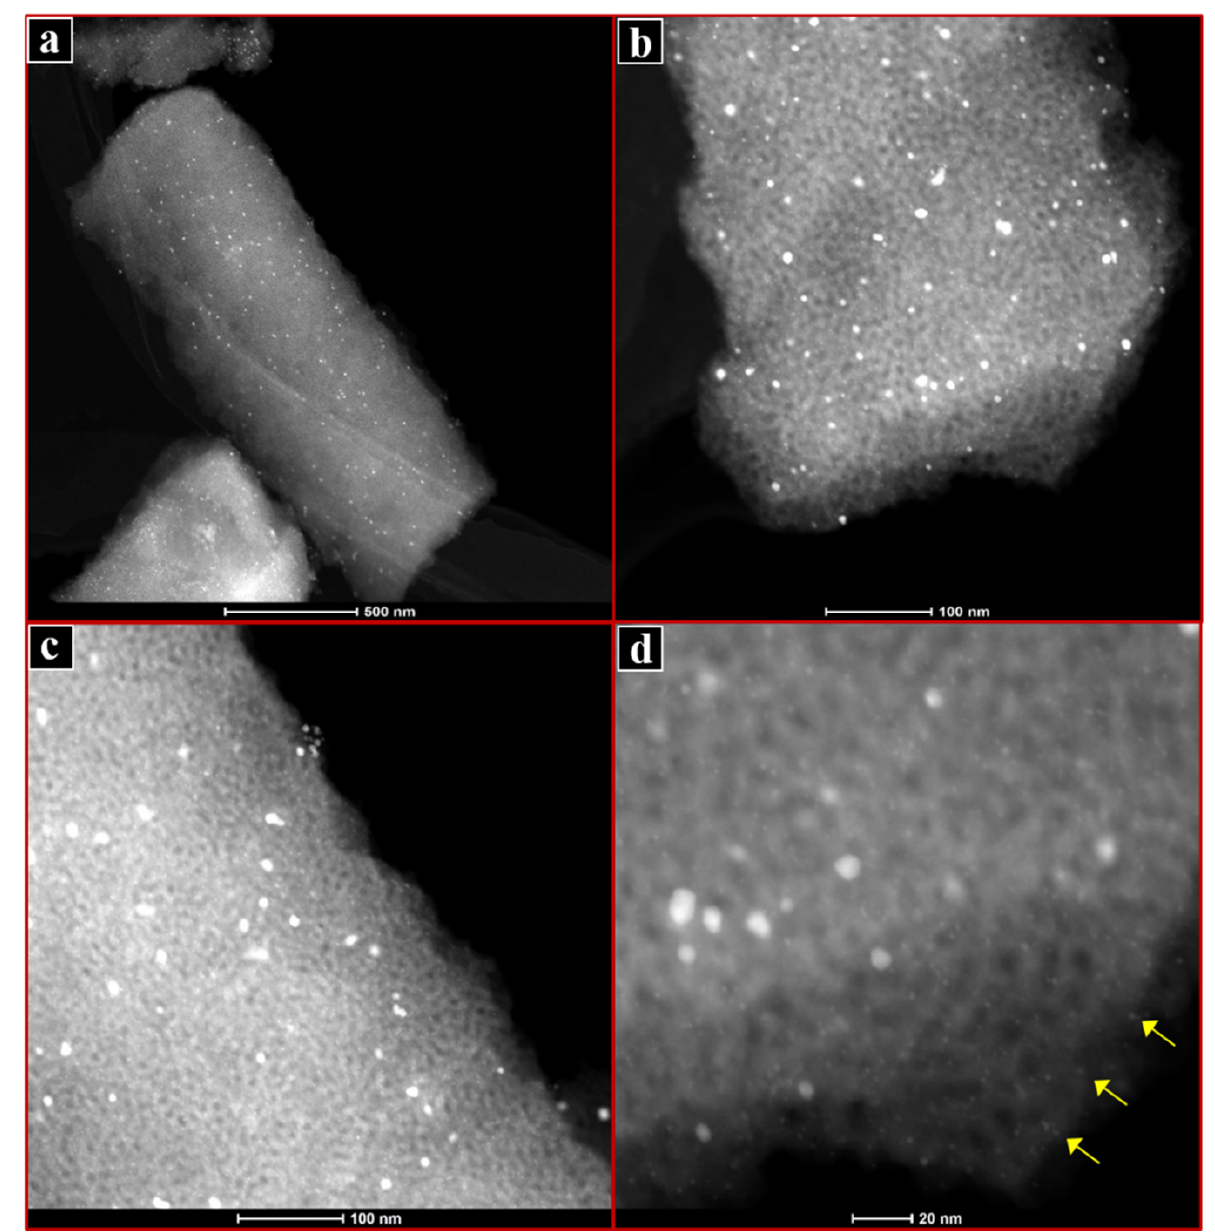
Figure 4. HAADF images of the catalyst IW-Pd after HDC testing in which Pd has bright contrast: ( a ) at low magnification showing the excellent dispersion of Pd nanoparticles within a particle of the mesoporous carbon support; ( b , c ) at inter- mediate magnification showing Pd nanoparticles and the pore structure more clearly; ( d ) at high magnification showing that in addition to the nanoparticles of ~3–8 nm diameter, even smaller features, possibly Pd clusters are visible (examples arrowed). The intermediate-sized Pd particles appear to coincide predominantly with the mesopores (dark contrast) of the support. A further image is given in Supplementary